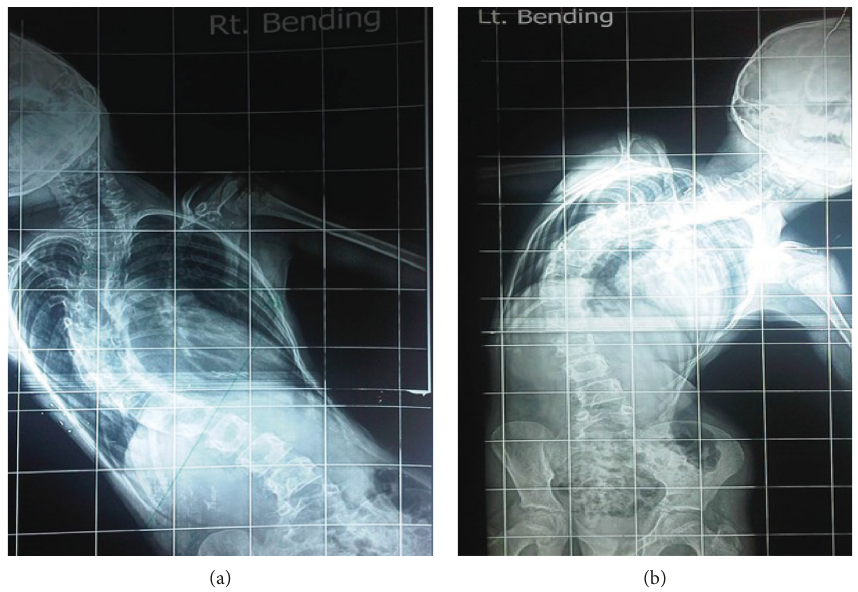
Figure 1: Preoperative X-ray showing right idiopathic thoracolumbar scoliosis.